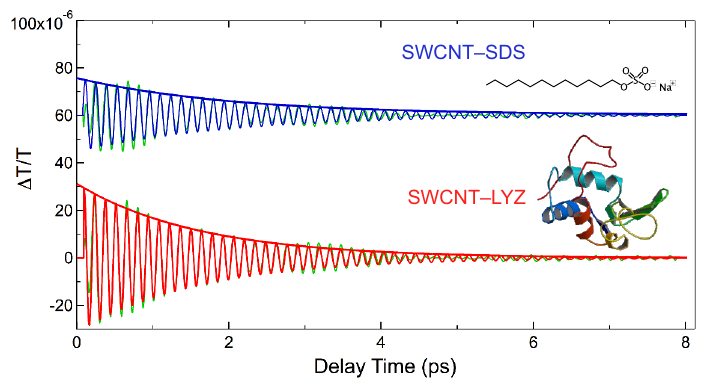
Fig. 1. Coherent phonon oscillations of SWCNT complexes observed using 830-nm excitation. The green line represents the experimental data, whereas the blue and red lines show the fits with Eq. (1). The upper and lower data correspond to SWCNT–LYZ and SWCNT–SDS, respectively. Insets show the structures of SDS and LYZ. The data of the time-domain oscillation were fitted by a linear combination of damped harmonic